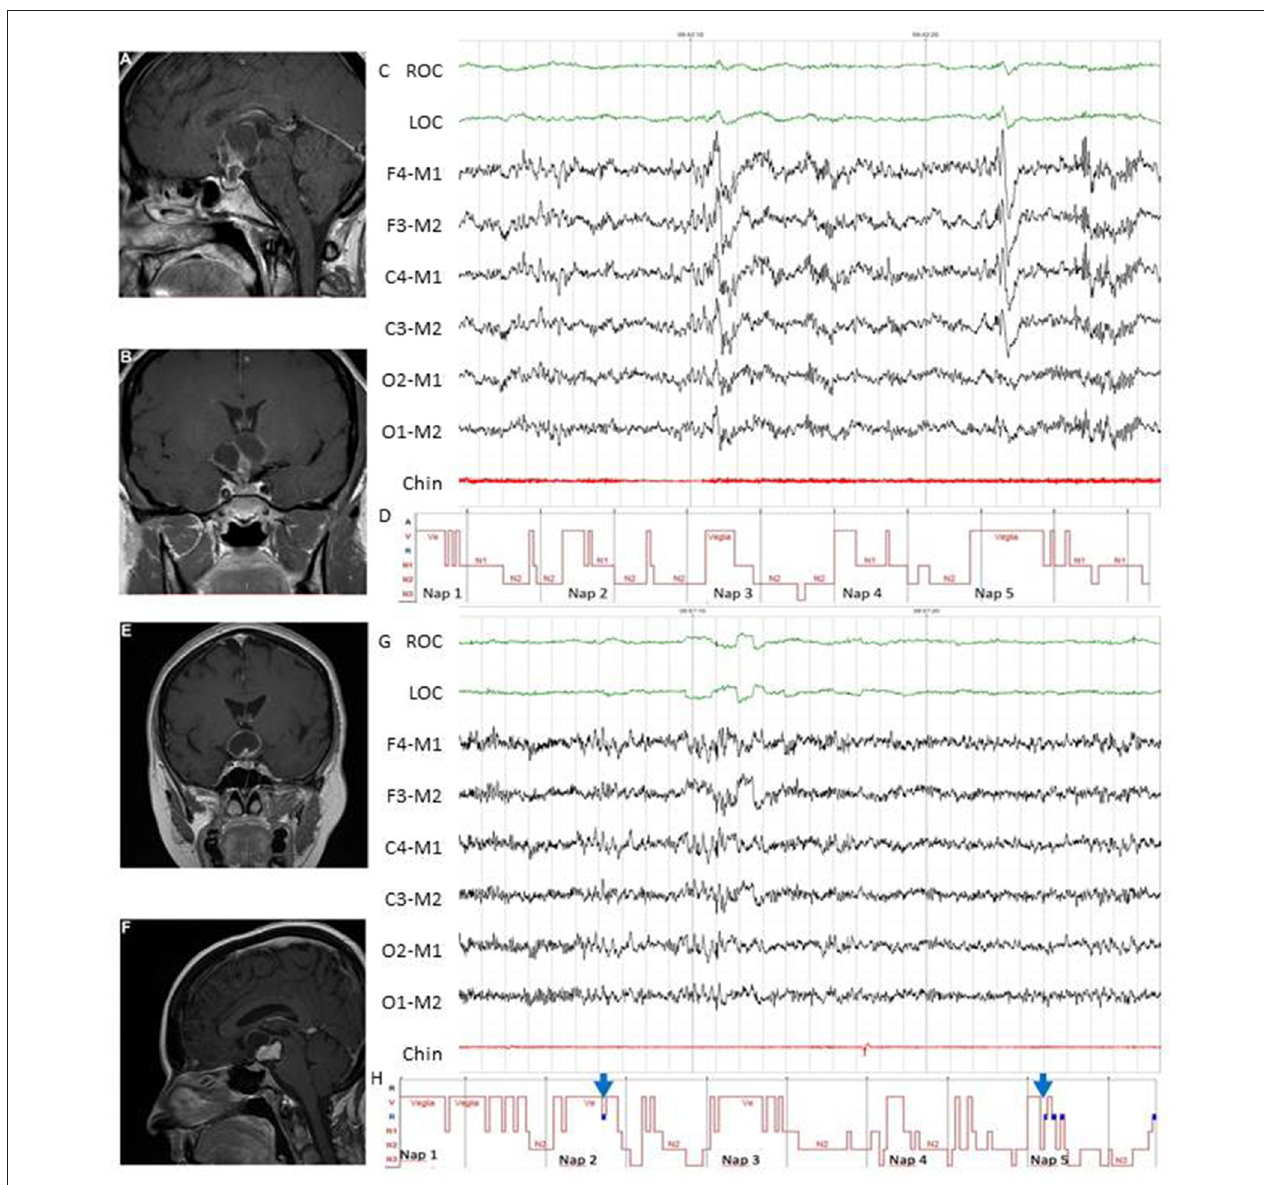
FIGURE 4 | Examples of MSLT in the diagnosis of central hypersomnias in two female patients with CP. Patient 1 (A–D) . Pre-operative evaluation of a 44-year-old woman who presented with spontaneous hypothalamic syndrome with severe weight gain ( + 30kg) associated with headache, secondary amenorrhea, asthenia, insomnia, and diurnal somnolence. Contrast-enhanced T1-weighted magnetic resonance imaging (MRI) revealed a huge solid and cystic suprasellar lesion [ (A) , coronal view] with posterior extension [ (B) , sagittal view]. MSLT showed a 30-s epoch of NREM sleep (N2) (C) with hypnogram confirming severe excessive daytime somnolence (mean sleep latency 4.2min) without sleep-onset REM in 5 of 5 nap periods (D) . A diagnosis of central hypersomnia was made. Patient 2 (E–H) . Post-operative evaluation of a 52-year-old woman affected by complex post-operative sleep disorders accompanied by diabetes insipidus, pan-hypopituitarism, ongoing severe weight gain ( + 7kg before surgery, + 30kg after surgery) and asthenia. Preoperative contrast-enhanced T1-weighted MRI showed a huge solid and cystic suprasellar lesion [ (E) , coronal view] with posterior extension [ (F) , sagittal view]. Excessive daytime somnolence persisted on continuous PAP for documented post-operative OSA (data not shown), and MSLT was recently proposed. The MSLT showed a 30-s epoch of REM sleep (G) , with hypnogram confirming severe excessive daytime somnolence (mean sleep latency 2.3min) with sleep-onset REM in 2 of 5 nap periods [ (H) , see blue arrows]. A diagnosis of secondary narcolepsy was made, and a stimulant oral agent (modafinil) was started. In both patients, complete tumor resection was achieved, and pathological examination revealed adamantinomatous (patient 1) and papillary (patient 2) craniopharyngiomas. ROC, right oculogram; LOC, left oculogram; M1 and M2 reference electrodes placed on the mastoid process; Chin, Chin